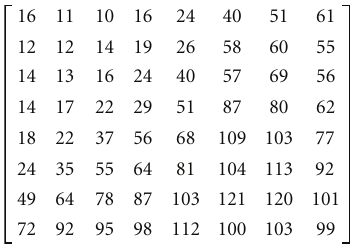
Figure 3: Luminance quantization matrix for JPEG.